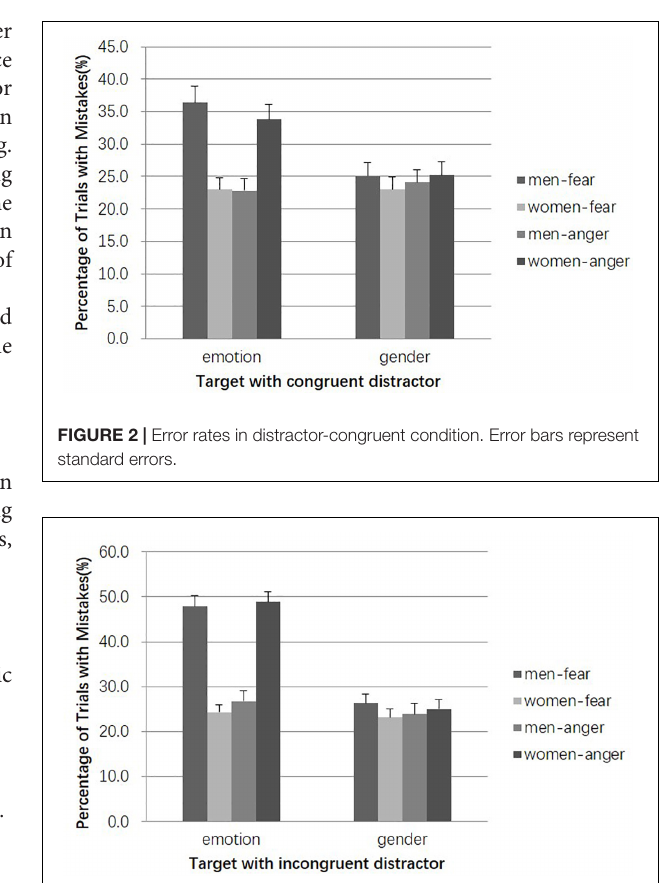
FIGURE 3 | Error rates in distractor-incongruent condition. Error bars represent standard